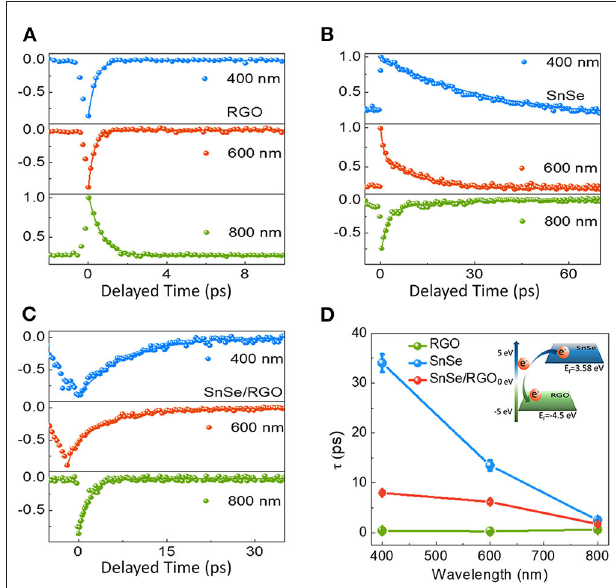
FIGURE 4 | Pump-probe experiment results of RGO (A) , SnSe (B) , and SnSe/RGO (C) at different excitation wavelengths: 400, 600, and 800nm. Scatter points represent experimental data and solid lines represent fitted results. (D) Photo-excited carrier lifetimes at different wavelengths. In the inset of (D) : Schematic diagram of electron transfer. Fermi-energy level alignment of SnSe [ 57] and RGO